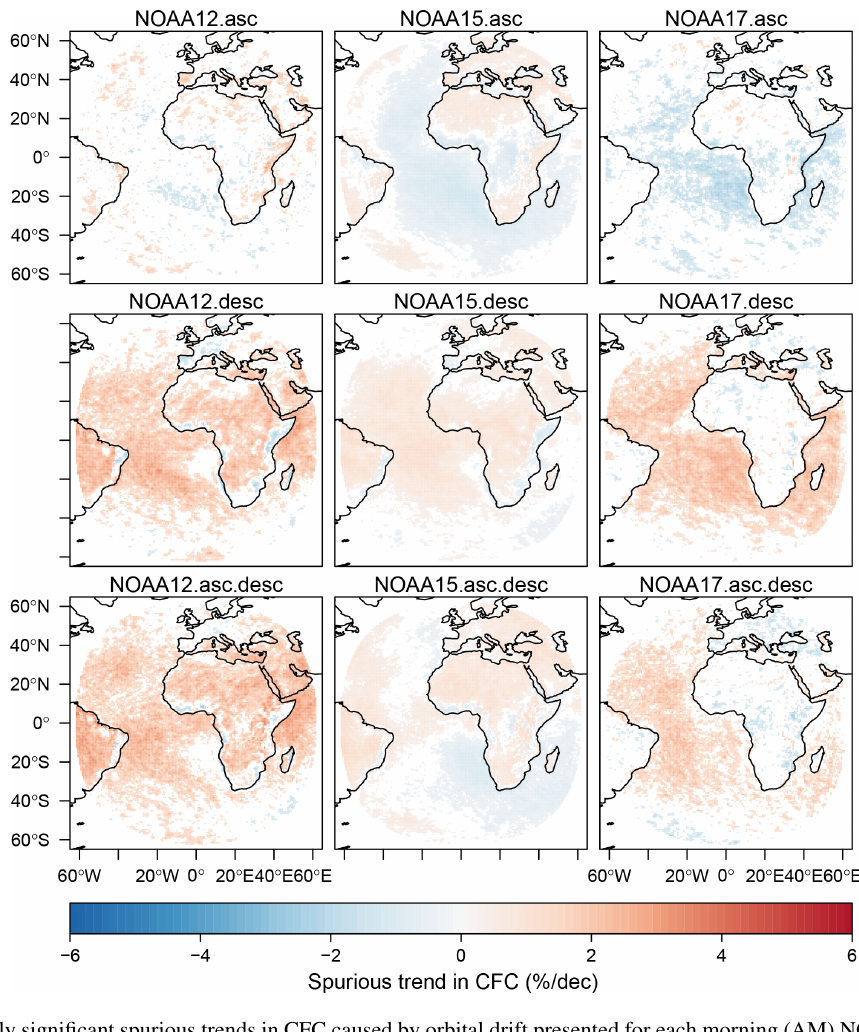
Figure 12. Statistically significant spurious trends in CFC caused by orbital drift presented for each morning (AM) NOAA satellite and each node (asc – ascending, desc – descending, and asc.desc – ascending and descending combined). Trends for the MetOp platforms are not presented due to lack of orbital drift.